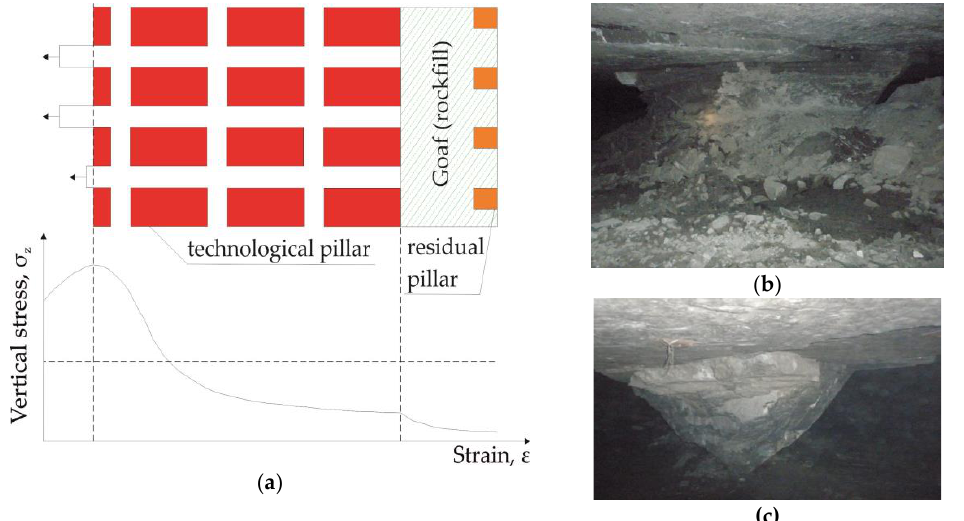
Figure 3 . Room and pillar method with roof deflection: (a) Scheme of the exploitation and an ideological stress-strain diagram; (b) Pillar before cutting; (c) Pillar after cutting. stress-strain diagram; ( b ) Pillar before cutting; ( c ) Pillar after